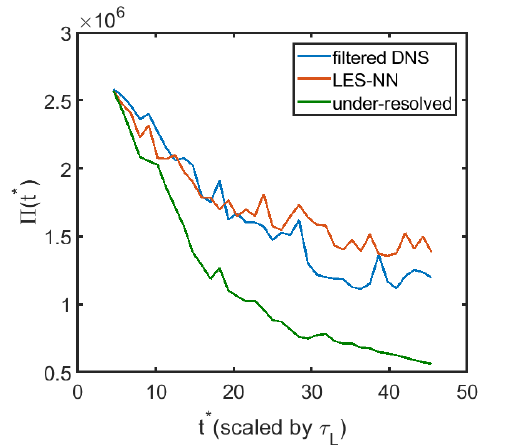
Figure 8. The evolution of the enstropy for the filtered DNS, LES and the under-resolved